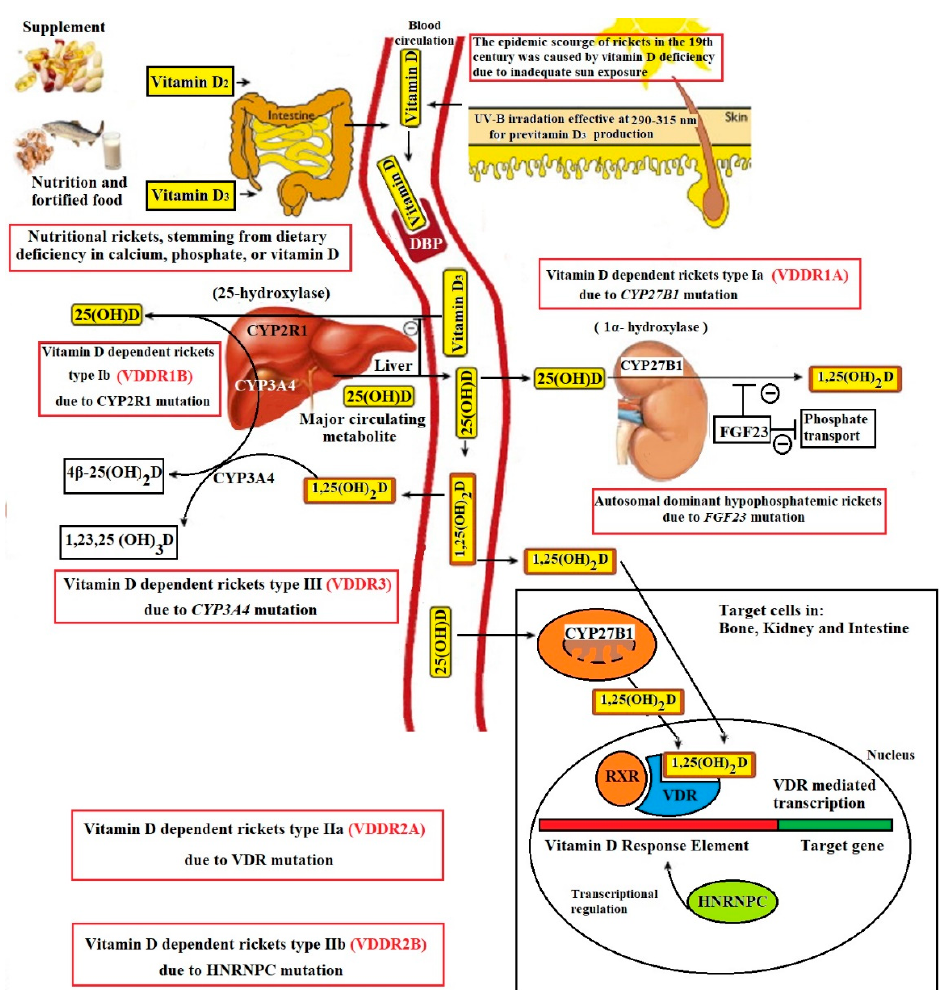
Figure 1. Schematic representation vitamin D metabolism and hereditary disorders affecting vita- min D pathway. Copyright Holick 2022. D pathway. Copyright Holick